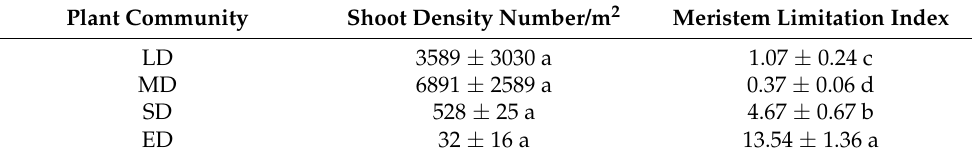
Table 4. Shoot density and the meristem limitation index of desertified grasslands. Plant Community